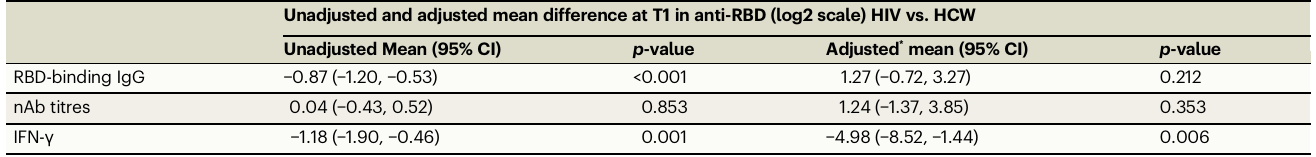
Table 2 | Adjusted difference in means from fi tting an ANCOVA model (contrasts between groups) Unadjusted and adjusted mean difference at T1 in anti-RBD (log2 scale) HIV vs.